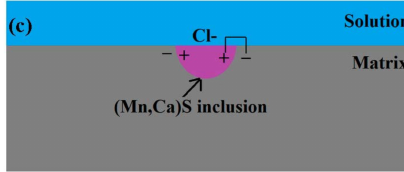
Figure 11. Schematic diagram of the inclusions’ effects on pitting corrosion initiation in X70 steel: ( a ) Type A; ( b ) Type B and ( c ) Type